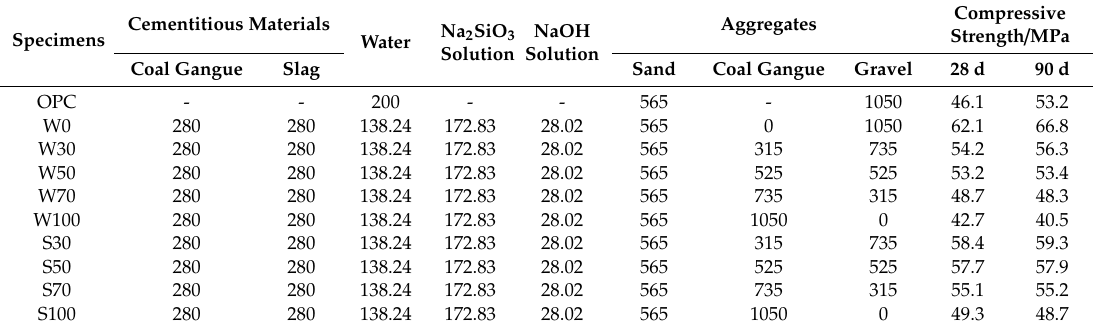
Table 3. Mix proportions of alkali-activated coal gangue-slag concrete (kg / m 3